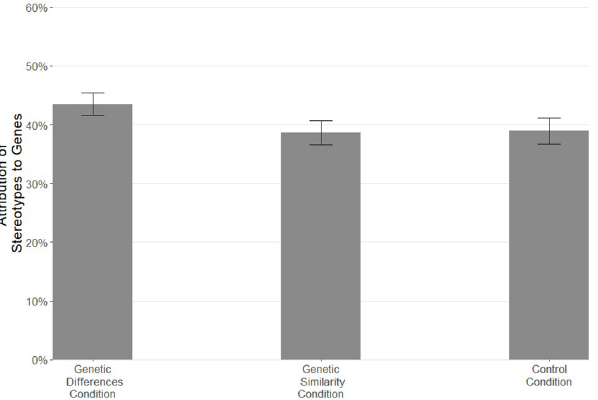
Fig 2. Mean attribution of stereotypes to genes by condition. Error bars are 95% confidence intervals.